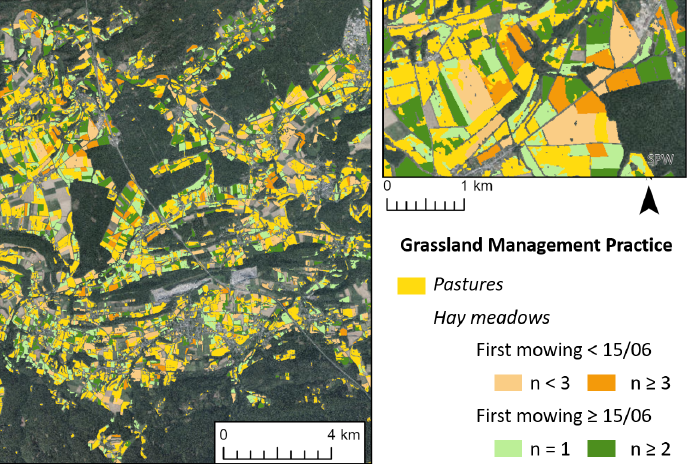
Figure 10. Grassland management practice classification. This hierarchical classification is based on the classification differentiating pastures from hay meadows and the mowing detection which further differentiates the second class by the date of the first mowing and by the number of mowing events